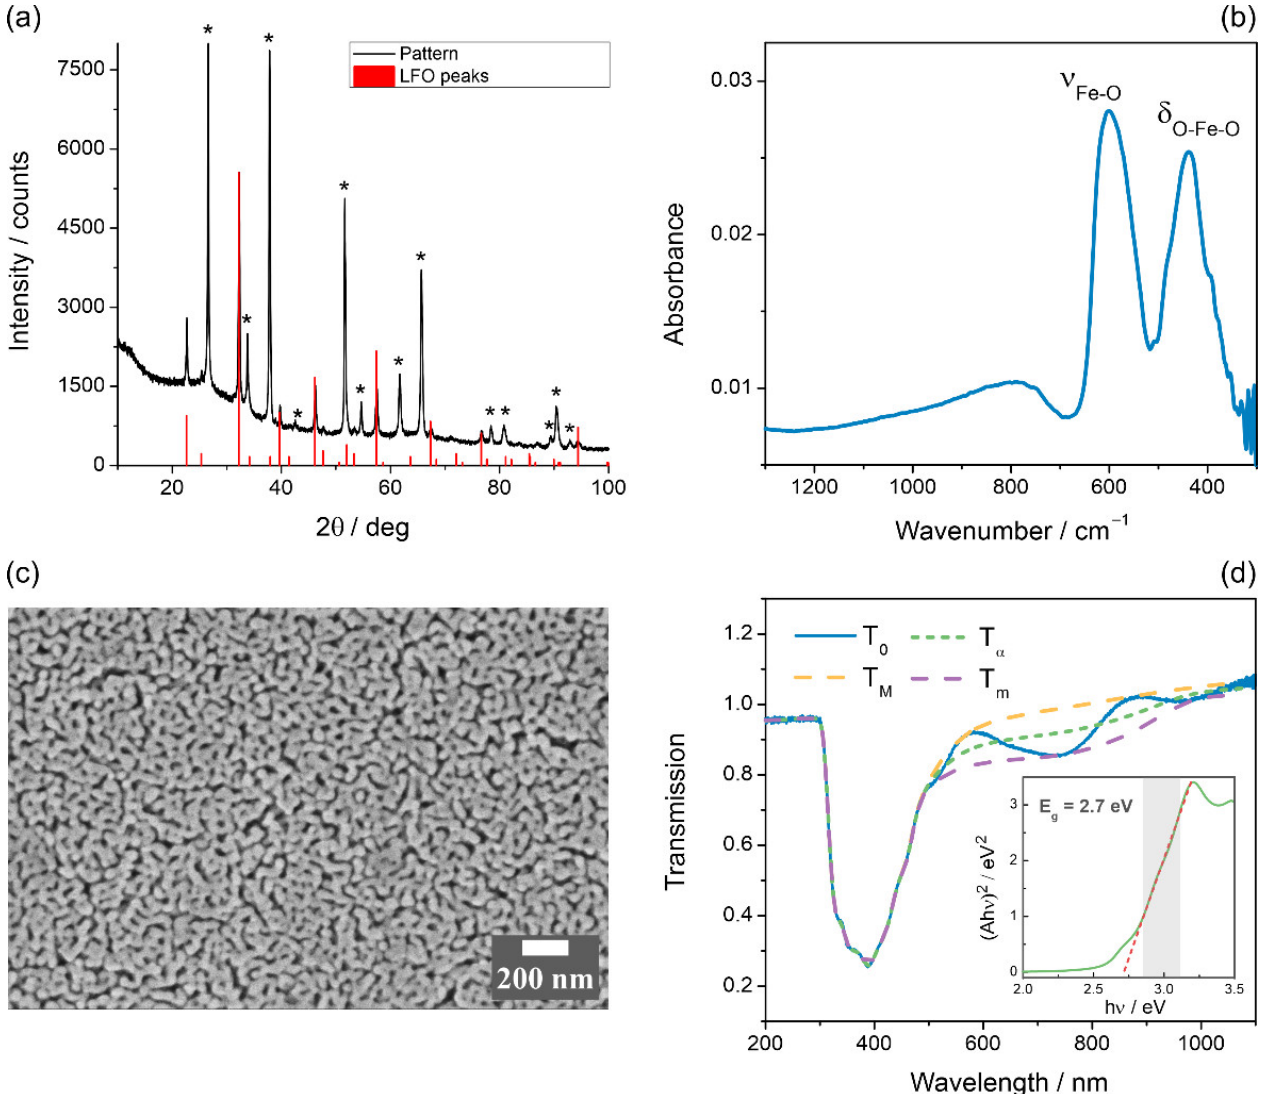
Figure 1. ( a ) XRD pattern of the LFO film on FTO. FTO peaks are marked with asterisks (*). LFO peaks are from ref. [46]. ( b ) ATR-FTIR spectrum of the LFO film. ( c ) SEM image of the LFO film. ( d ) Optical absorption spectrum of the LFO photoelectrode. The insert shows Tauc plot constructed to determine the band gap energy (E g ).